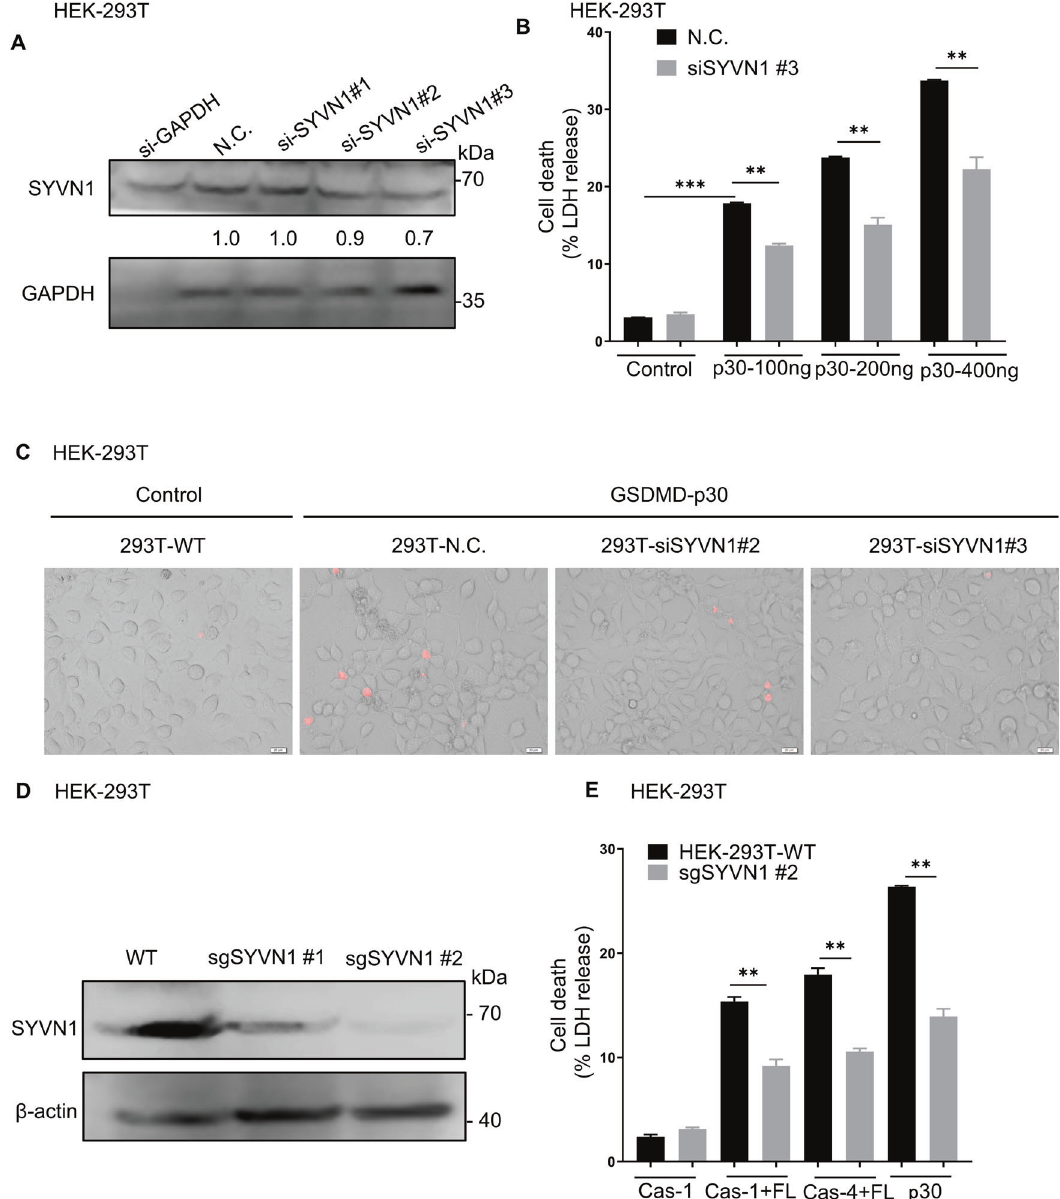
Fig. 4 Effect of inhibiting SYVN1 on GSDMD-mediated pyroptosis in HEK293T cells. A Immunoblotting analysis for ef fi ciency of SYVN1 knockdown in HEK293T cells using siSYVN1. The analysis was performed using an anti-SYVN1 antibody. B , C HEK293T cells were transfected siSYVN1-control (50 nM) or siSYVN1 (50 nM), 48 h after transfection, cells were transfected with hGSDMD-p30. The supernatants were collected and analyzed by LDH release assay. After 24 h transfection, the cells were stained with PI (2.5 μ g/ml) and analyzed by fl uorescence microscopy. D The ef fi ciency of SYVN1 knockout was analyzed by immunoblotting with anti-SYVN1 antibody in HEK293T cells obtained from WT and SYVN1-KO HEK293T cells. E HEK293T WT and SYVN1-KO cells were transfected with caspase-1/4 and hGSDMD-FL or hGSDMD-p30 alone. The supernatants were collected and analyzed by LDH release assay. All results are representative of at least three independent experiments. K203 and K204 residues in GSDMD. The mass spectrometric (Fig. 3), and as such, loss of SYVN1 function impairs GSDMD- analysis further revealed two high-con fi dence ubiquitin-modi fi ed mediated pyroptosis (Figs. 4, 5). In general, SYVN1 promotes residues in the N- (K51) and C-terminal (K299) domains of GSDMD GSDMD-mediated pyroptosis. (Supplementary Fig. 5A). However, a mutation in these residues There were multiple K residues in GSDMD that can be (K51R/K299R) had no signi fi cant effect on GSDMD ubiquitination, ubiquitinated based on the prediction by Ubipred online software. suggesting that SYVN1 also modi fi es other lysine residues. A These residues could be ubiquitinated by SYVN1 and other E3 recent study revealed that pyroptotic cell death is independent of ubiquitin ligase enzymes, and further studies are needed to GSDMD-K204T modi fi cation [58]. In contrast, we found that identify these ubiquitin ligases. Herein, we found that SYVN1 GSDMD-K204R mutant inhibited GSDMD-induced pyroptosis. The promotes pyroptosis mainly by interacting and ubiquitinating